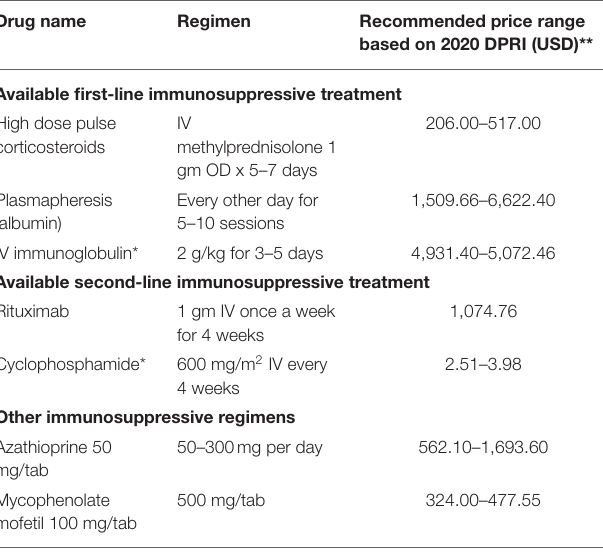
TABLE 3 | Sample costing of treatment for autoimmune encephalitis in the Philippines